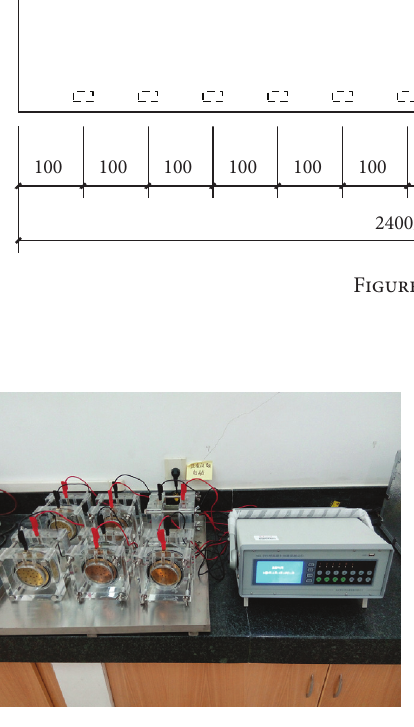
Figure 4: NEL-PEU instrument.